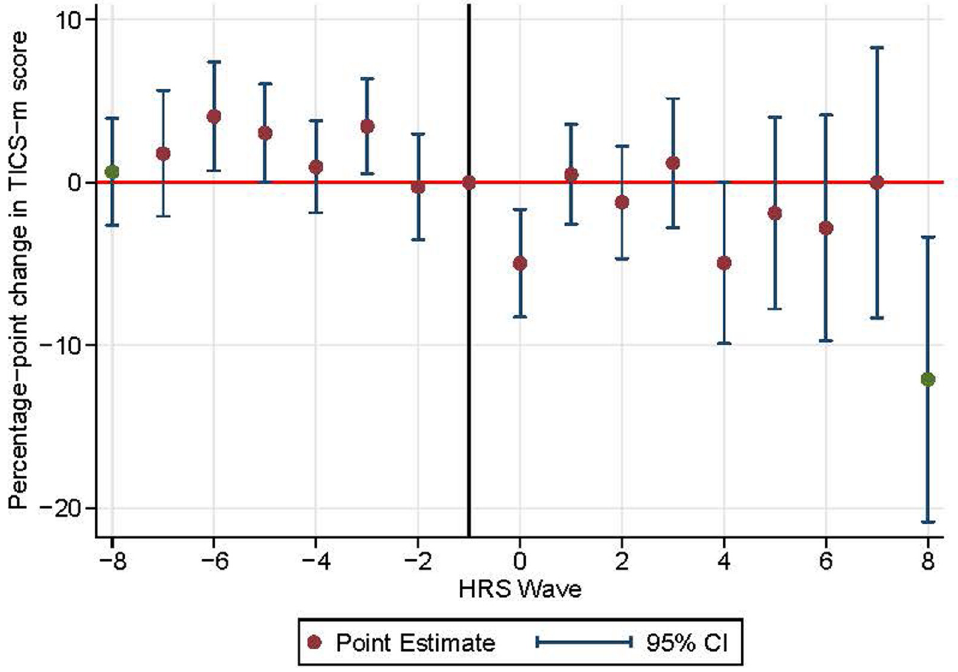
Fig 4. Event study plot for female